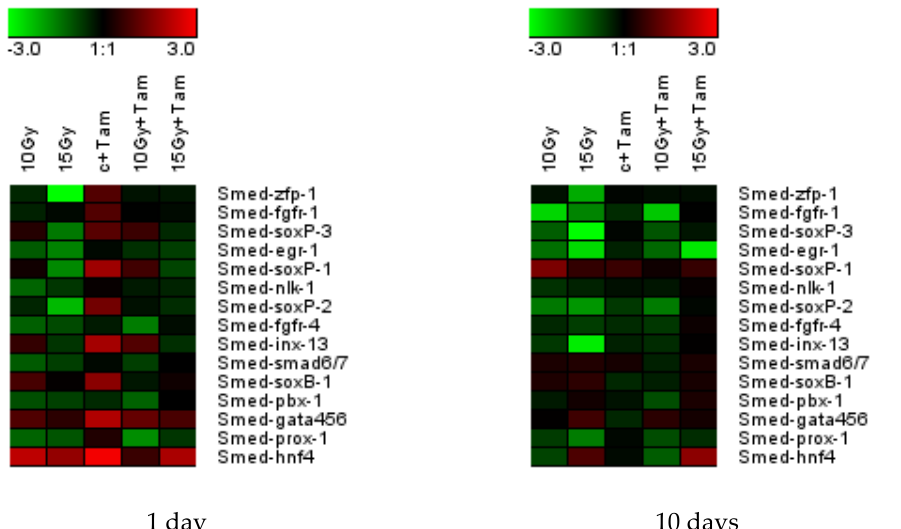
Figure 3. Tameron stimulates expression of neoblast marker genes. The figure shows a heatmap reflecting changes in expression of a test panel of neoblast marker genes in planarians after irradiation and/or treatment with Tameron (Tam) (10 − 4 M) compared to unirradiated and untreated animals. The scale of intensity of the standardized expression values extends from − 3 (green: low expression) to +3 (red: high expression). The 1:1 intensity value (black) represents the non-treated control. The measurements were made on the first and on the tenth day after irradiation.